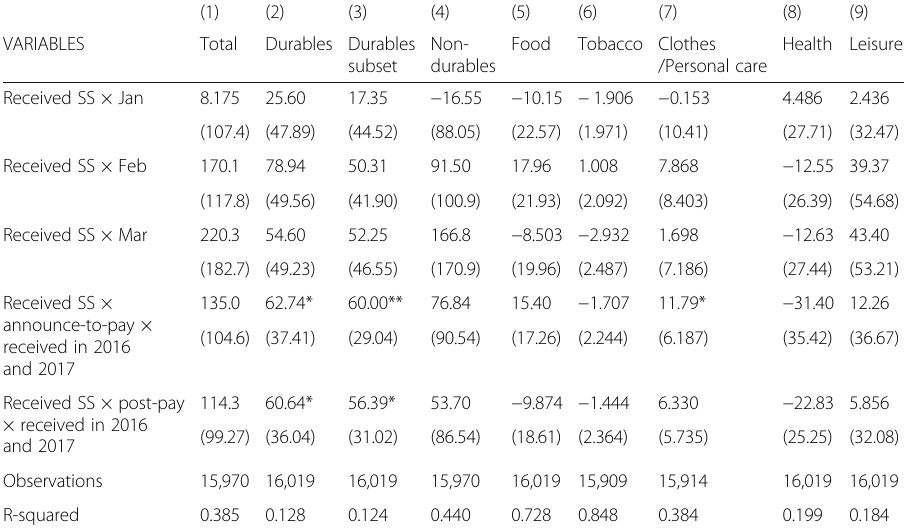
Table 23 Robustness check for expenditure — accounting for misreporting of SSS payout